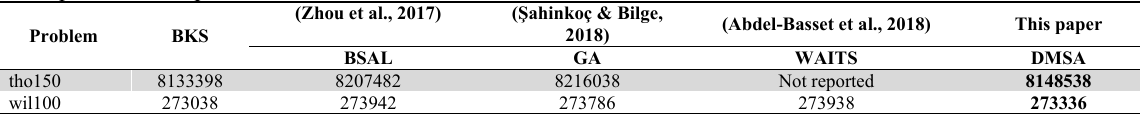
A comparison of the performances of different methods on tho150 and will100 (Zhou et al., 2017) Problem BKS